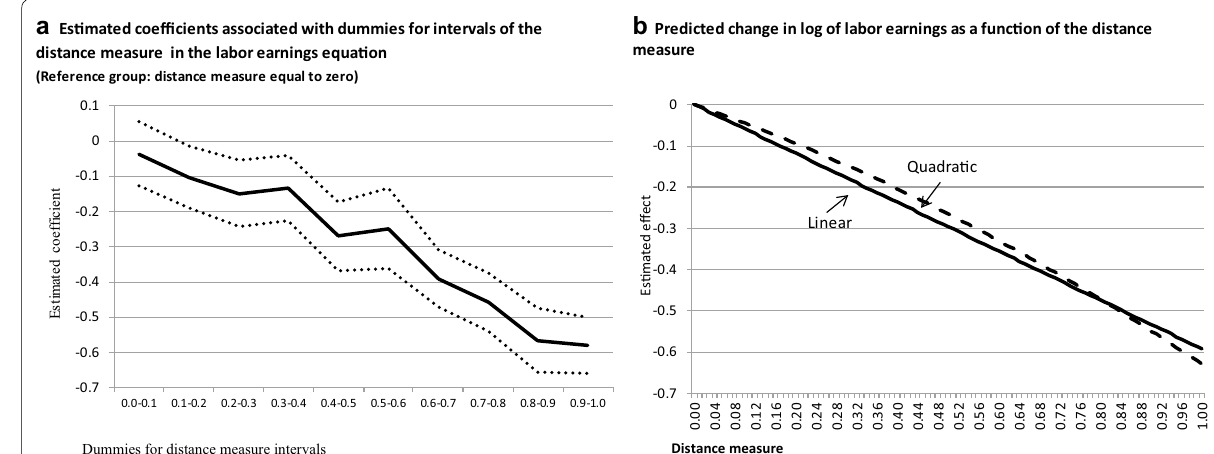
Fig. 3 Hourly labor earnings and the occupation‑field of study mismatch: non‑linear specifications. Note: The dependent variable is the logarithm of the hourly labor earnings. All regressions are estimated by OLS and control for age, age squared, a dummy for female, a dummy for black, regional dummies and dummies for fields of